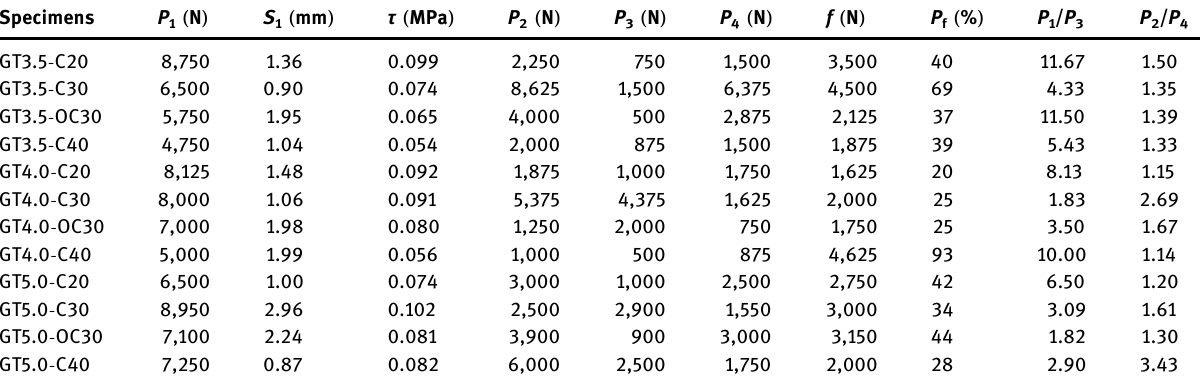
Table 5: Experimental results of